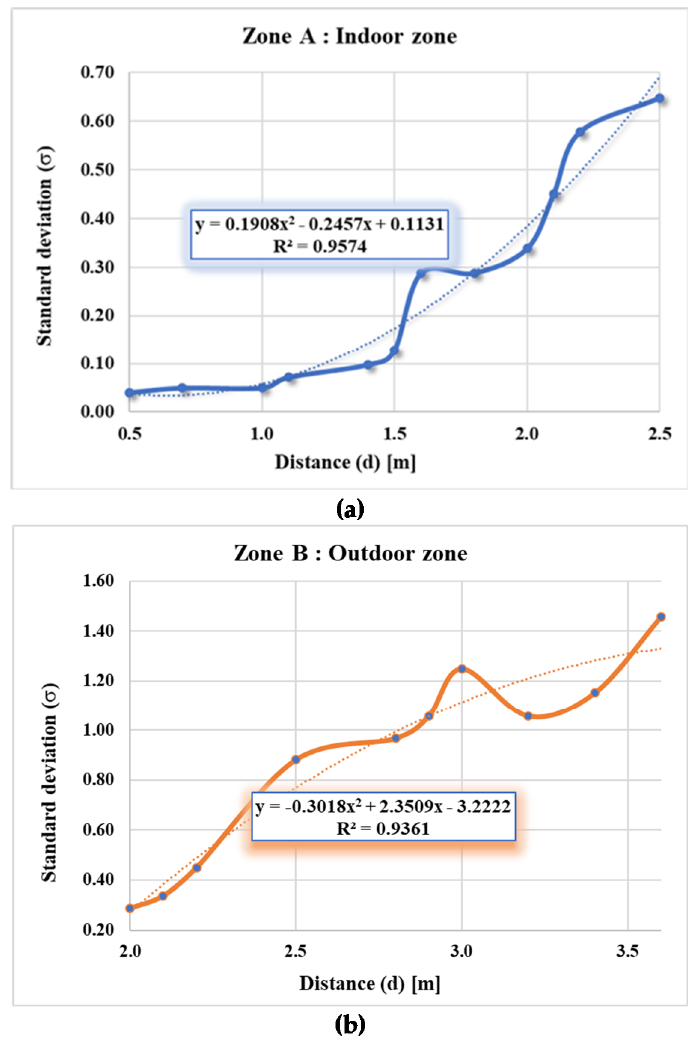
Figure 4. Relationship of the noise standard deviation and distance for measured data of ( a ) Zone A and ( b ) Zone B.